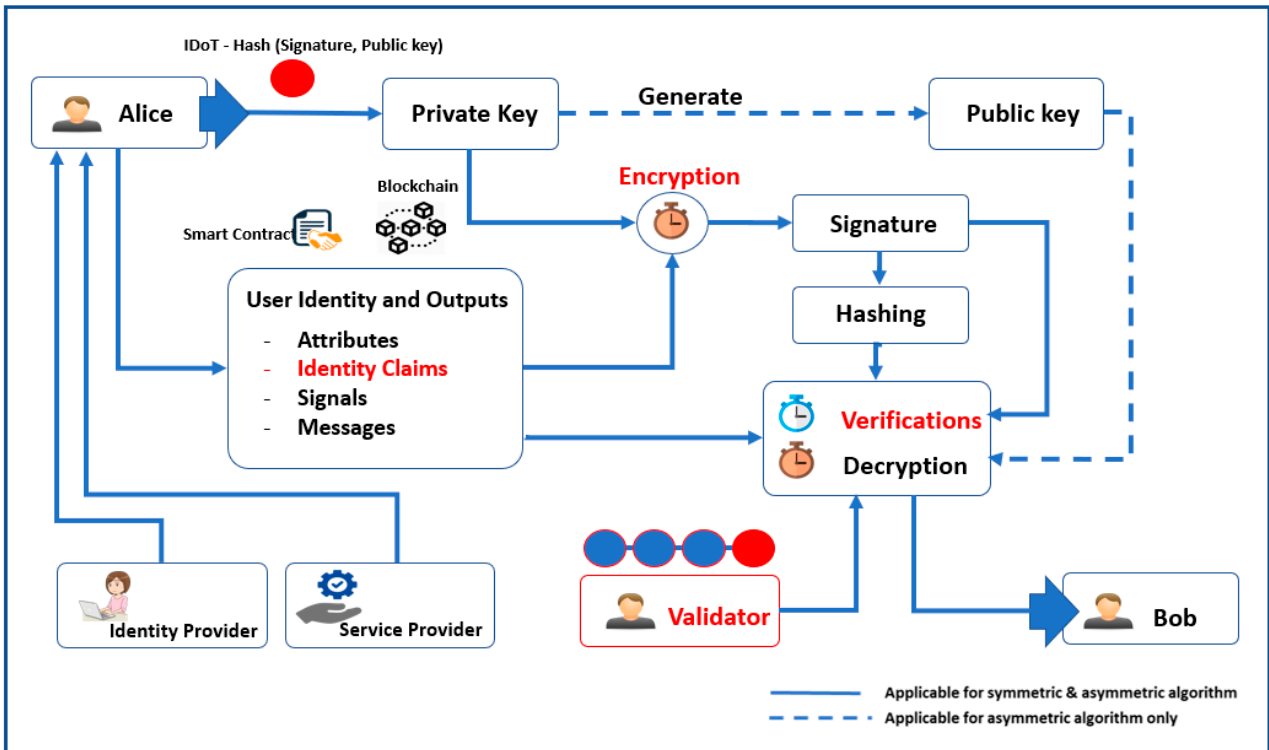
Figure 2. Architecture of proposed permissioned blockchain network identity management